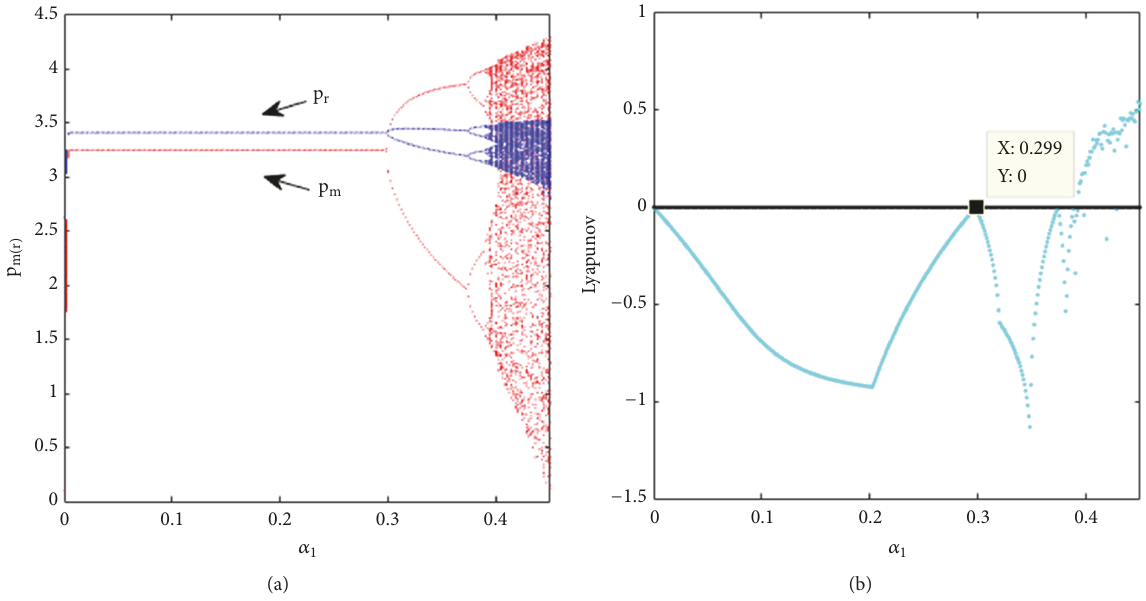
Figure 9: Bifurcation diagram and Lyapunov exponents with 𝛼 1 when 𝛼 2 = 0.1 . (a) Bifurcation diagram. (b) Lyapunov exponents.